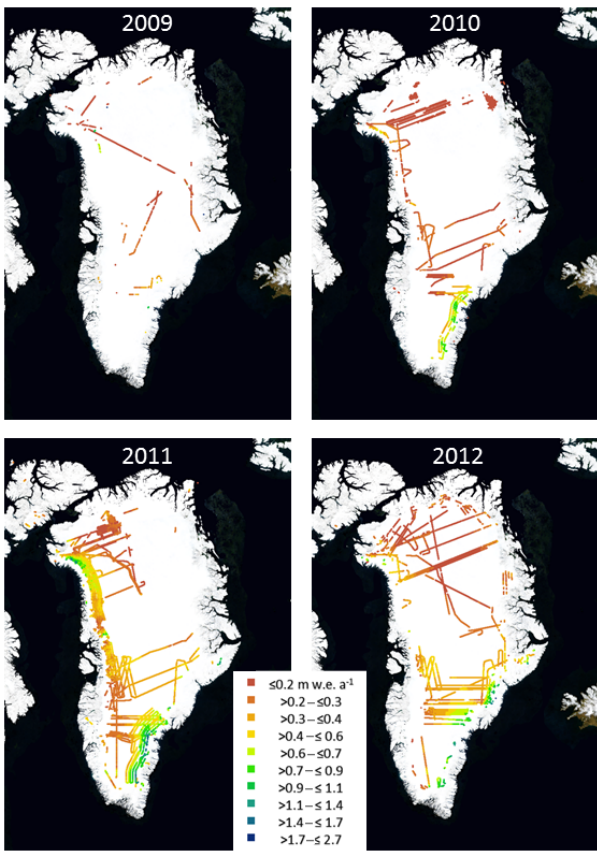
Figure 5. Modeled estimates of annual accumulation (mw.e.a − 1 ) over the GrIS for 2009 through 2012 from the Modèle Atmo- sphérique Régional (MAR) regional climate model (v3.5.2) (rep- resenting 1 July to 30 April to match the radar-derived